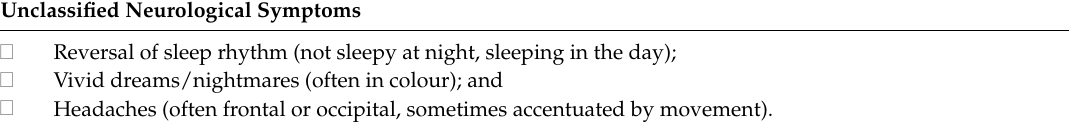
Table 3. Neurological symptoms of patients observed in endemic and epidemic cases [1,3]. Cognitive Dysfunction